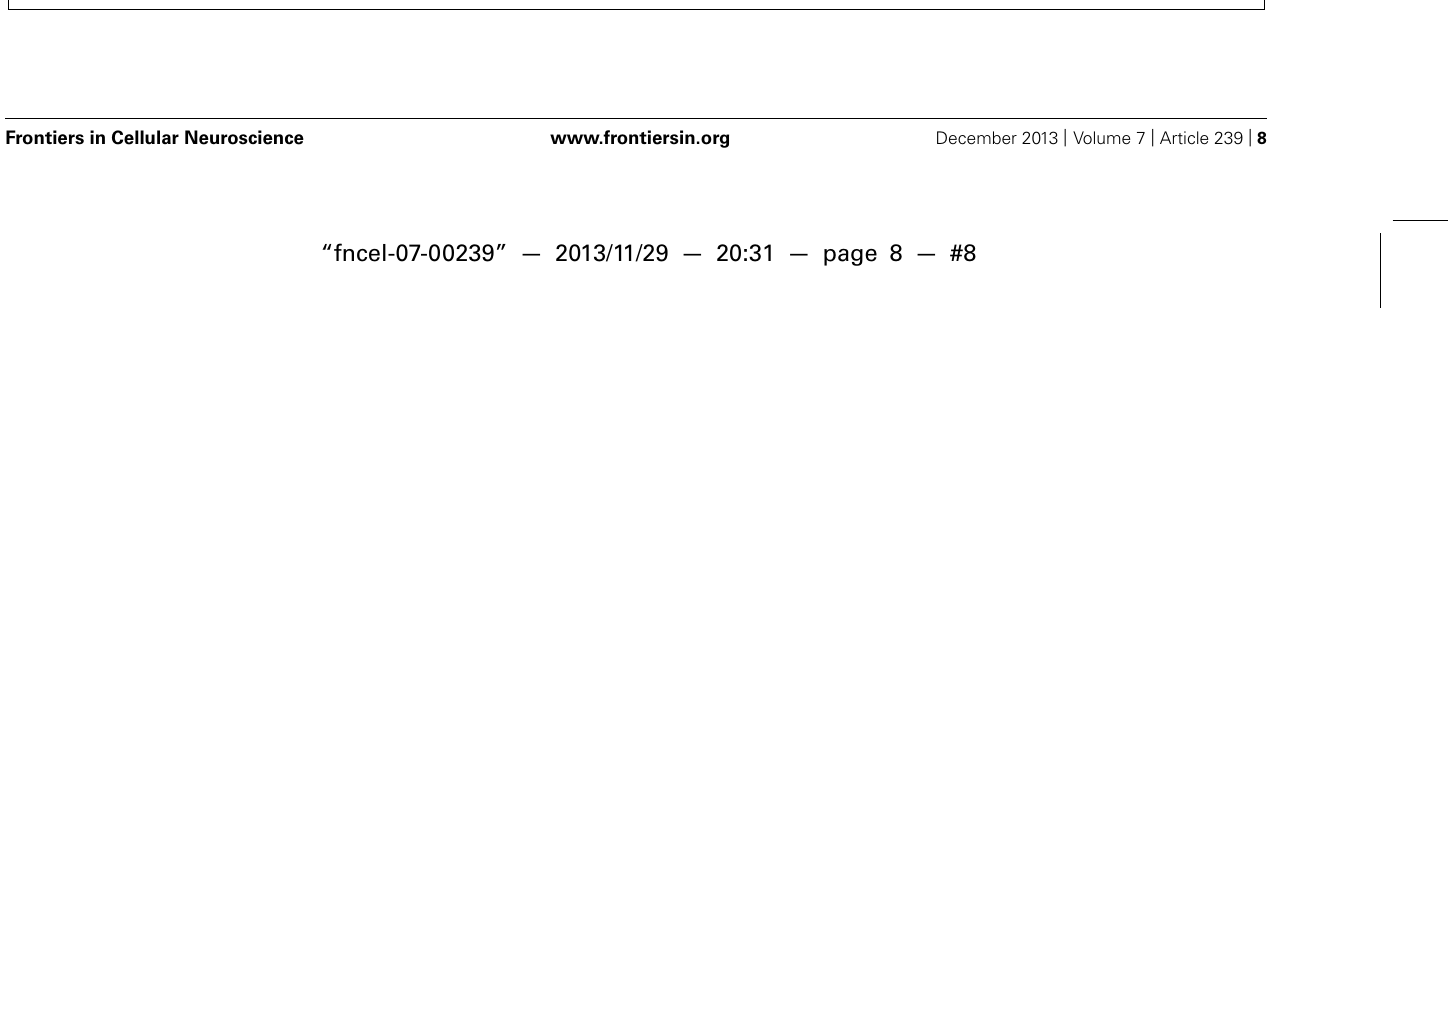
Hb9 and the internal control GAPDH. (C) Western blot analyses were performed with specific antibodies against Hb9 and the internal control α -tubulin.The bottom panel shows quantification of the data, which is expressed as the mean ± SEM of four independent experiments (* p < 0.05). (D) Immunocytochemical analyses show that Hb9 is localized in the nuclei of all cells, but the intensity of the staining is less evident in differentiated NSC34hSOD1G93A cells. Cells were also stained with MAP1B and nuclei withToPro-3. Bar, 20 (A) and 50 μ m (D)